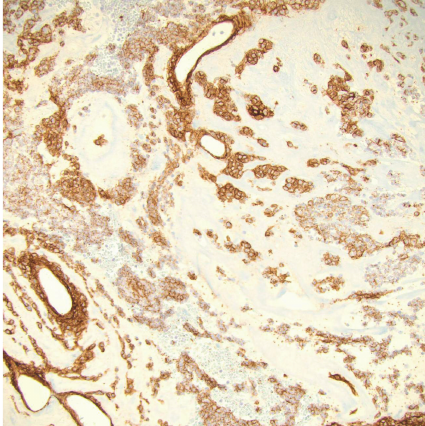
Figure 5: High power microscopic image of a Collagen Type IV immunostain demonstrating pericellular net-like staining around the round blue cells (Collagen Type IV immunostain,